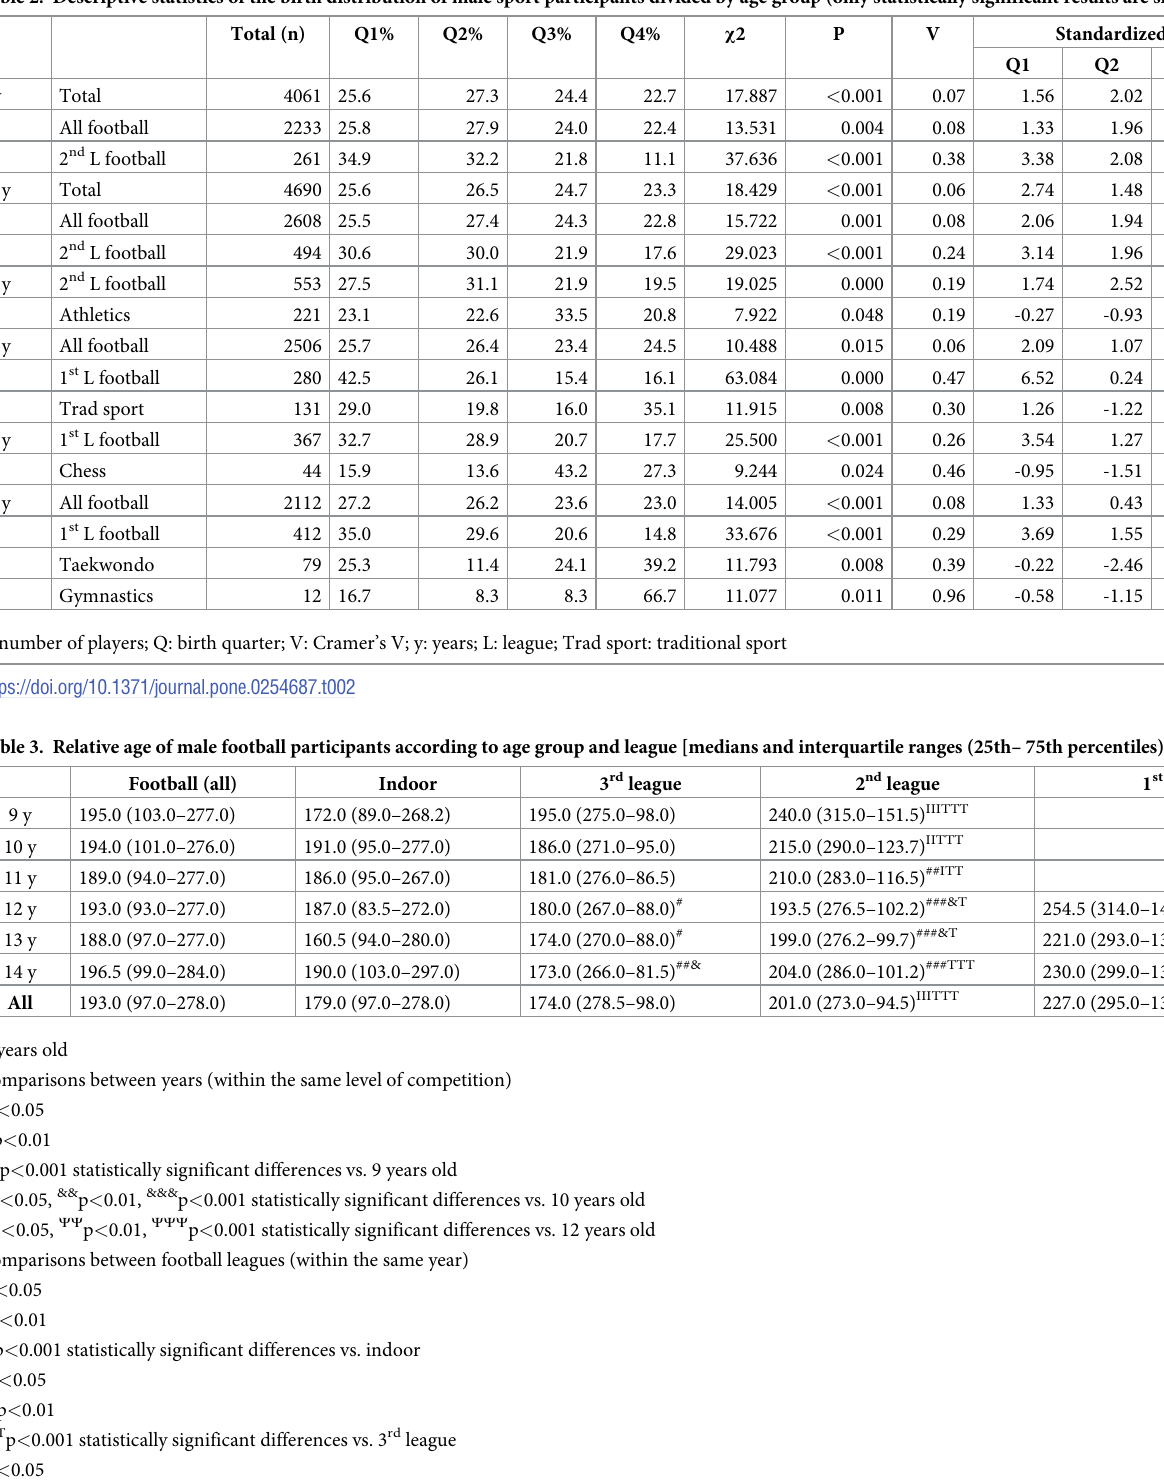
Table 2. Descriptive statistics of the birth distribution of male sport participants divided by age group (only statistically significant results are shown).